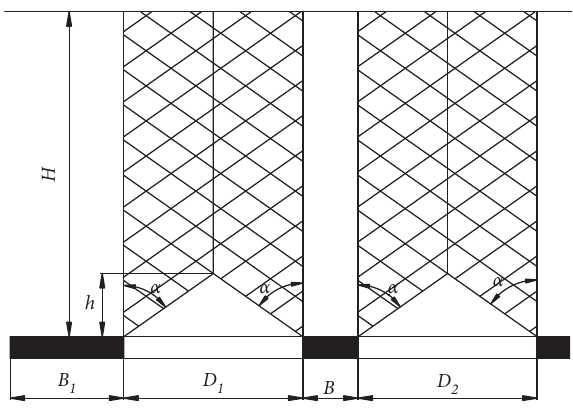
Figure. 5: Estimation model of overlying coal seam stress.